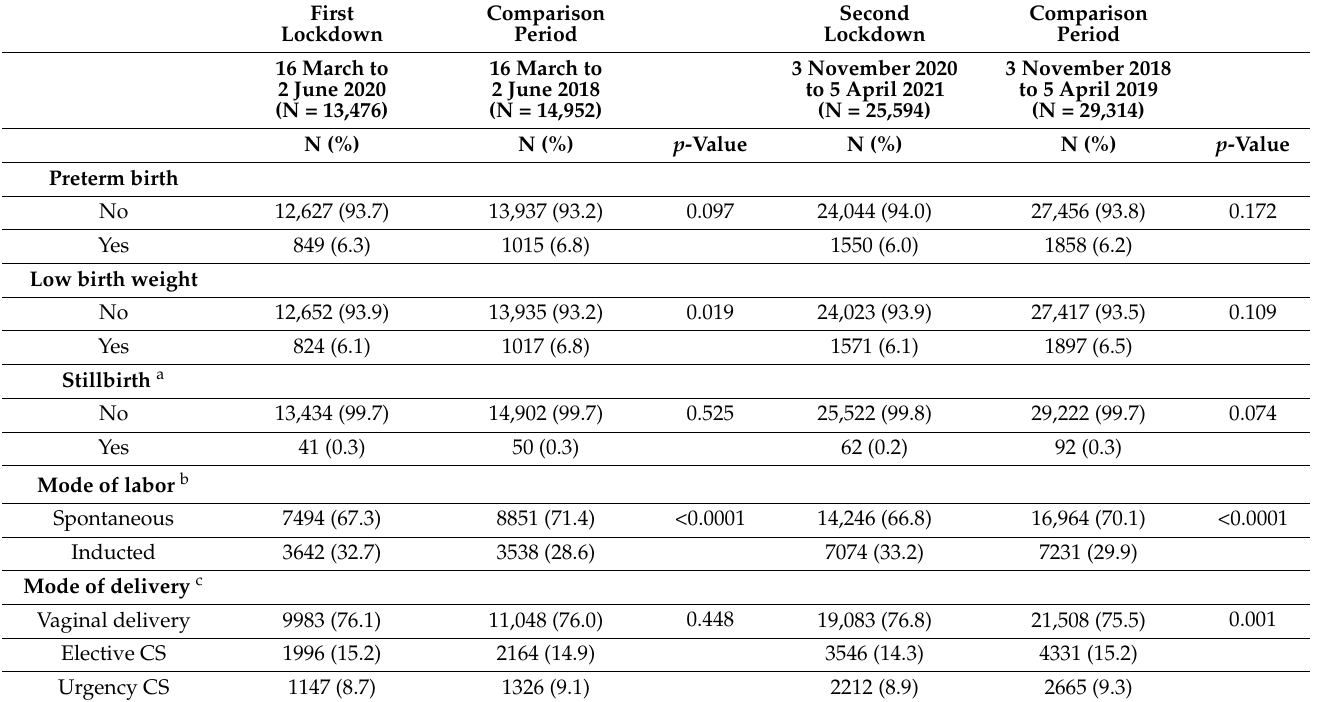
Table 1. The distribution of births according to selected perinatal outcomes, mode of labor, and mode of delivery during lockdowns and comparison